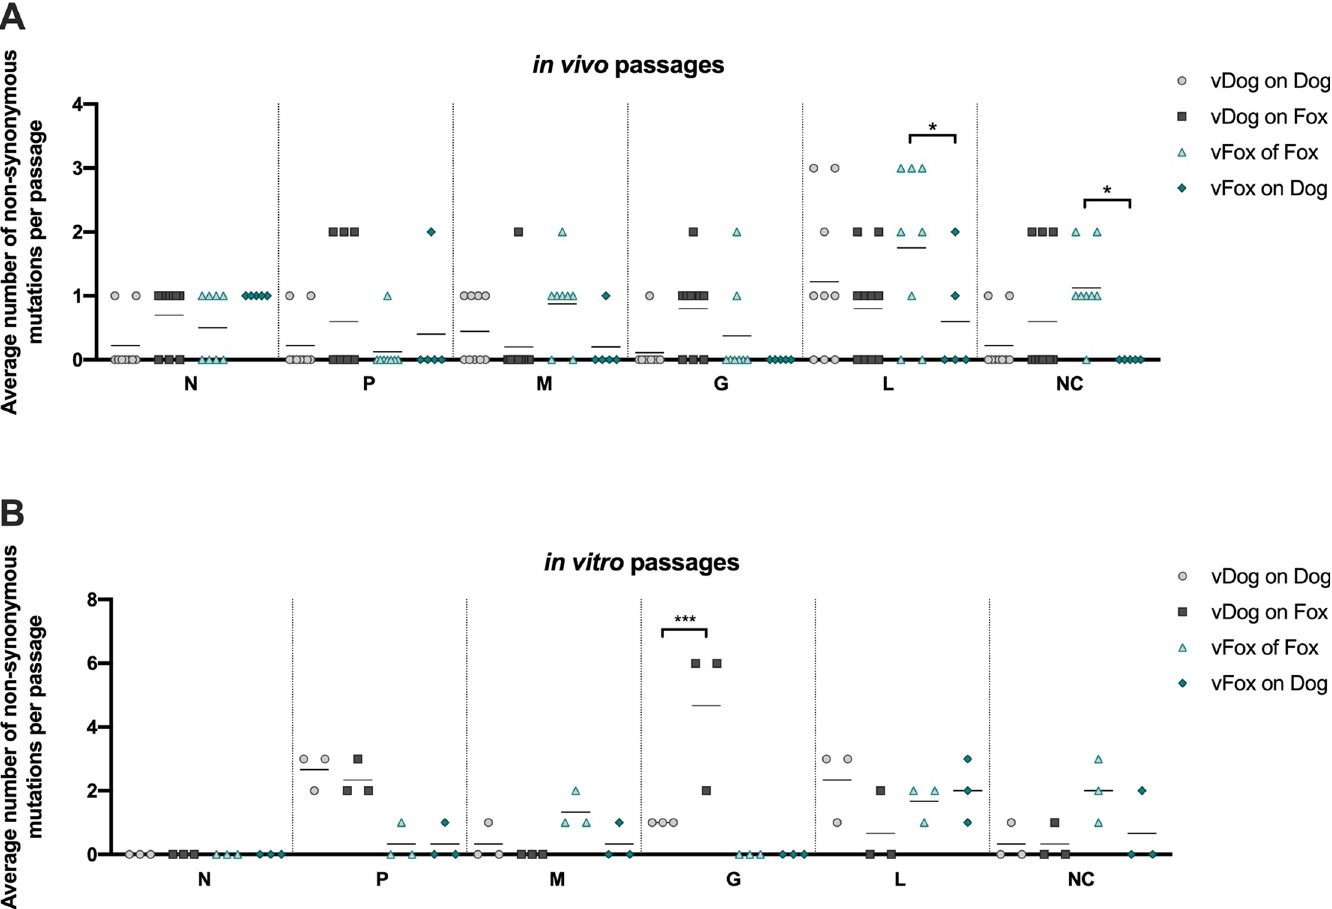
Fig 2. Distribution of non-synonymous mutations across the RABV genome. The number of non-synonymous mutations were examined in each region of RABV genome (N, P, M, G and L genes and the non-coding (NC) regions) and are represented by a dot plot. The average number of mutations were assessed per region and per animal for in vivo passages (A) or per cell culture for in vitro passages (B). Statistical analysis (Tukey’s multiple comparison test) was performed using GraphPad Prism software. � P < 0.01; ��� P < 0.0001. Error bars correspond to standard deviations.